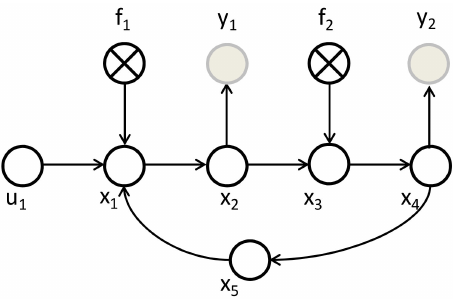
Figure 1. Exemplary GP graph. Notation: u—inputs, y—control signals, f—faults, x—process variables (state